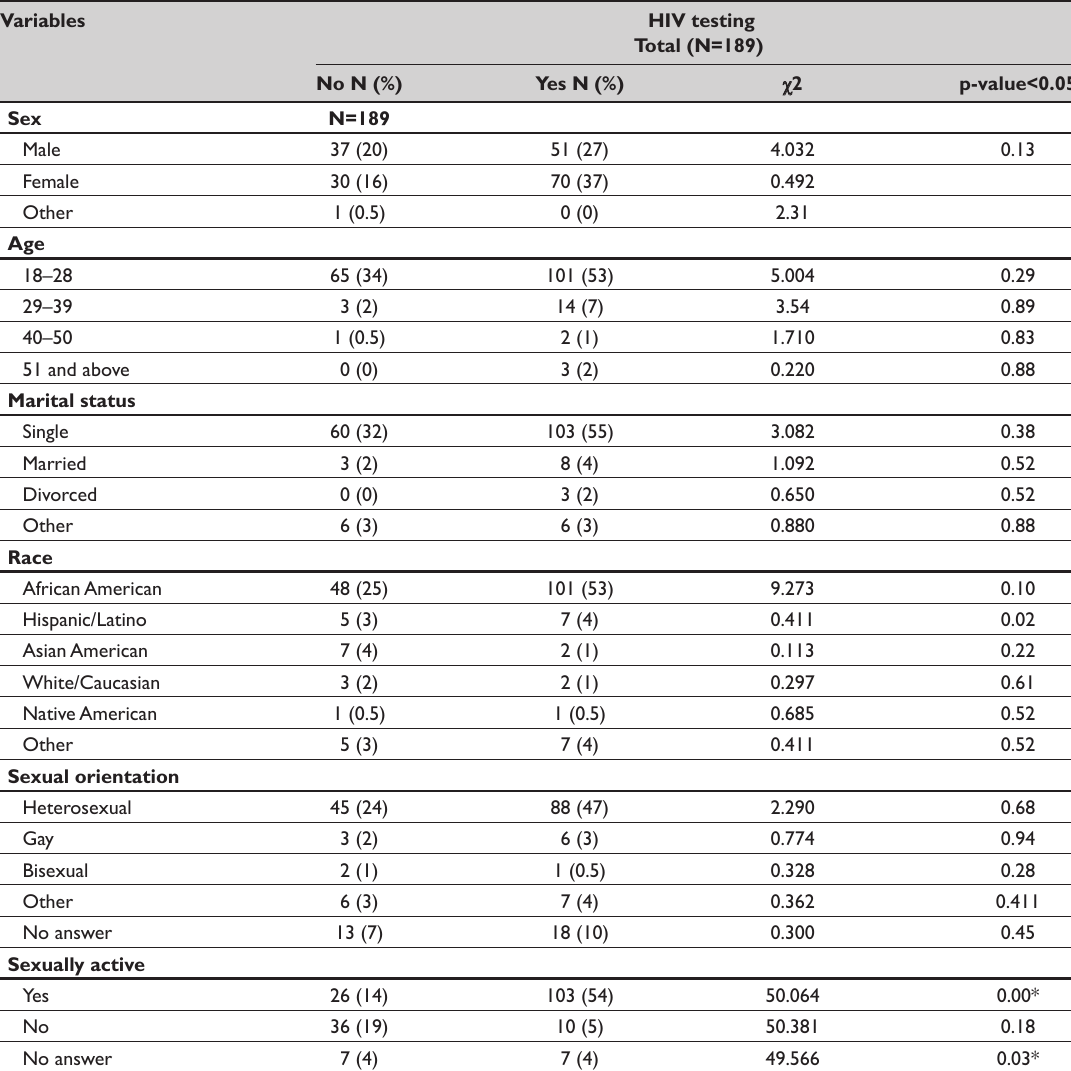
Table 4: Bivariate analysis of the association between selected demographic characteristics, and HIV testing among college